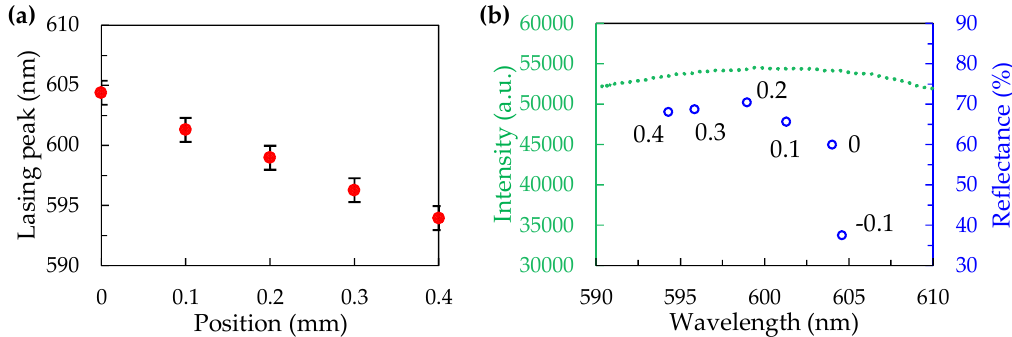
Figure 6. ( a ) The shifted peak wavelength of the lasing spectrum of the sample depending on di ff erent positions; ( b ) The peak wavelengths and reflectance of the reflection spectrum of the silica CC filled NOA 164 at di ff erent positions along with the fluorescence spectrum of the DCM-doped NOA 164.